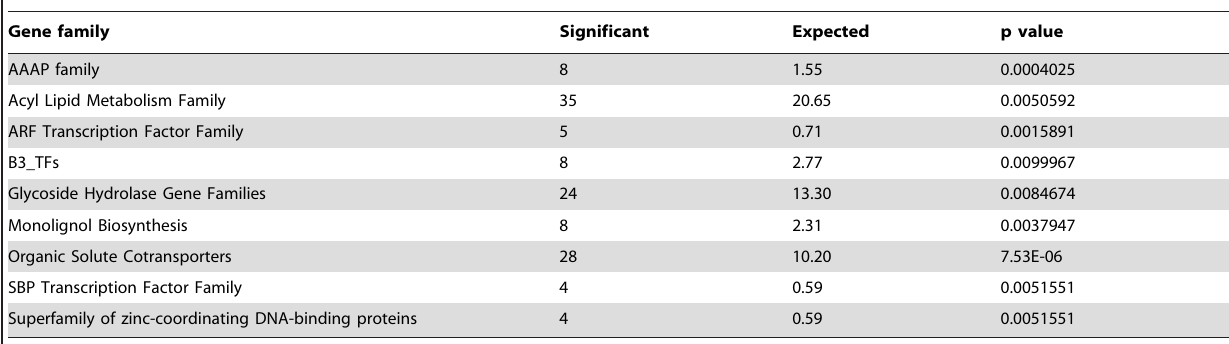
Table 6. Gene family enrichment.